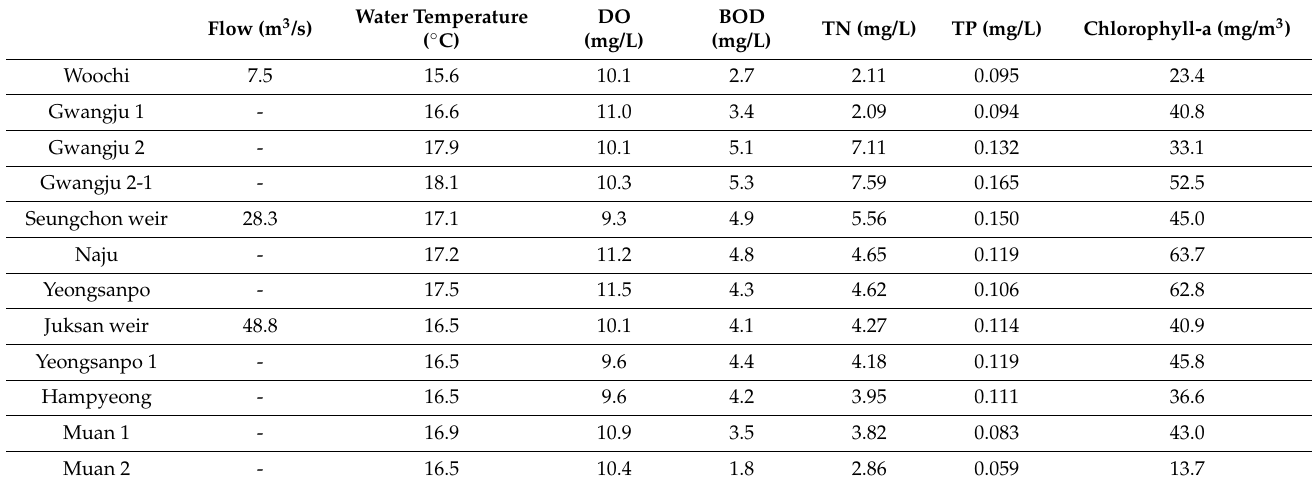
anobacteria were not measured at the Muan 2 point (estuary dam).